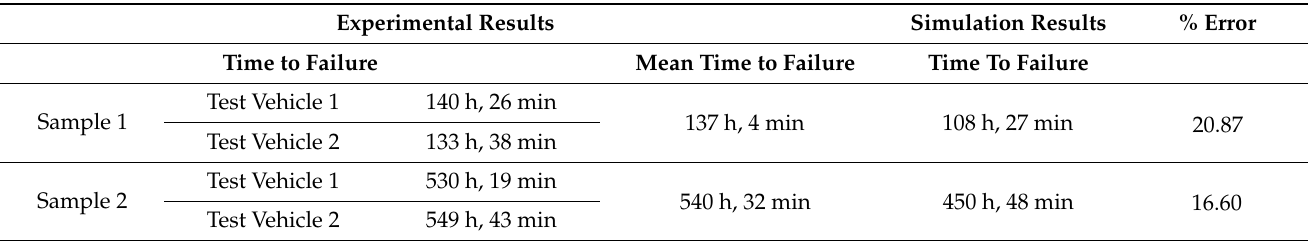
Table 5. Comparison of Experimental and Simulation Results.